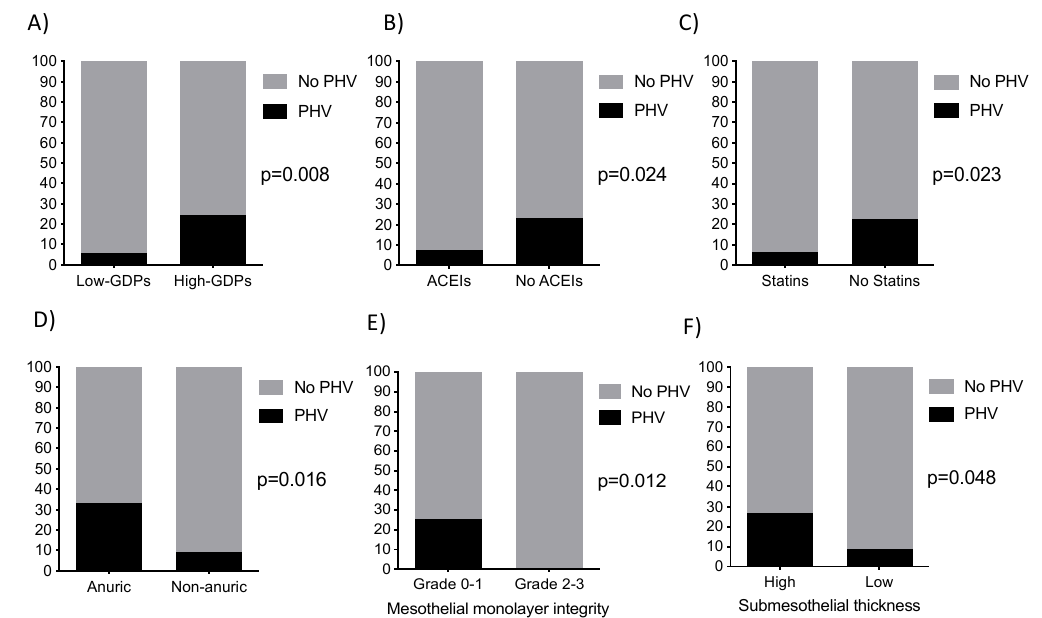
Figure 2. Prevalence of PHV was significant lower in patients using ( A ) biocompatible peritoneal dialysis (PD) solutions, ( B ) angiotensin converting enzyme inhibitors (ACEIs) and ( C ) statins. Patients with preserved residual renal function ( D ), peritoneal mesothelial integrity ( E ) and lower peritoneal fibrosis ( F ) also showed significantly lower PHV prevalence.